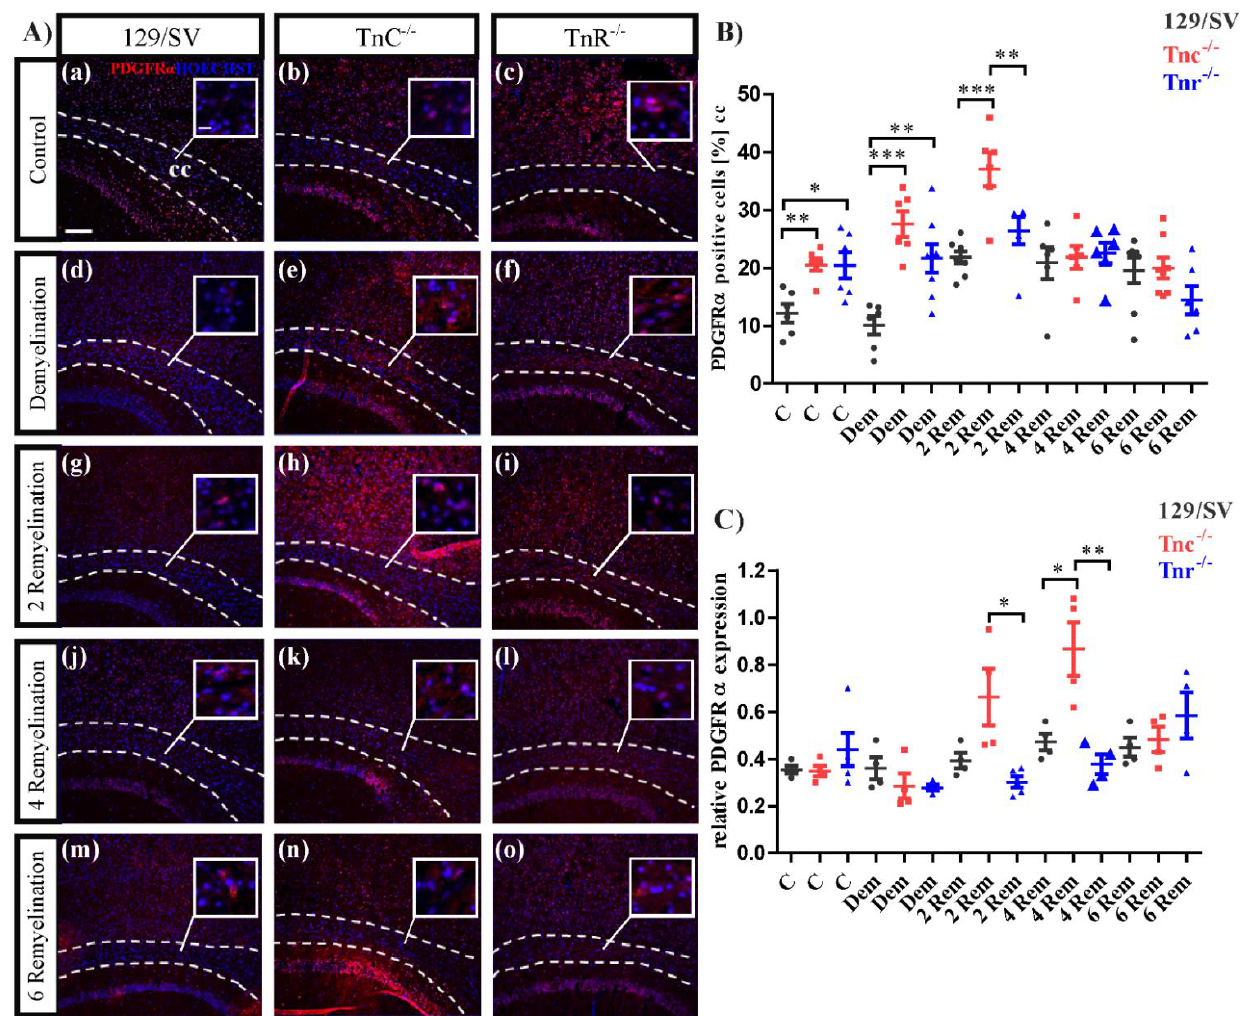
Figure 6. Differential recruitment of oligodendrocyte precursor cells (OPCs) in the Tnr −/− and Tnc −/− genotypes. ( A ( a – o )) Sagittal sections of 129/SV, Tnc −/− and Tnr −/− mice exposed to cuprizone were immunohistochemically stained with an antibody against PDGFR α (red) in the conditions, control (C), demyelination (DM), 2-, 4- and 6 weeks of remyelination (RM2, RM4 and RM6). Hoechst was used as a marker for cell nuclei (blue). Images show the caudal part of the corpus callosum (CC) above the hippocampus (HC), circle triangle squares show a better visualization of the cells. Both, Tnc and Tnr knockout leads to a significant increase of OPCs in the control condition ( A ( a – c ), B ) and during demyelination ( A ( d – f ), B ). This effect was also observable in the early stage of recovery, after 2 weeks of remyelination ( A ( g – h ), B ). However, with ongoing duration of remyelination, no differences between the several genotypes were observable and determinable. Additionally, RT-PCR analysis for the determination of the PDGFR α expression in the three different genotypes in the five different conditions was performed ( C ). The results revealed a significantly higher PDGFR α expression during remyelination stages in Tnc − / − mice, indicating that Tnc impairs the OPC maturation in general. Data are presented as mean ± SEM and statistical significance ( p ≤ 0.05 *, p ≤ 0.01 **, p ≤ 0.001 ***) was assessed using the ANOVA and Tukey’s multiple comparison test (control, demyelinated, remyelinated). Four independent experiments were performed (N =